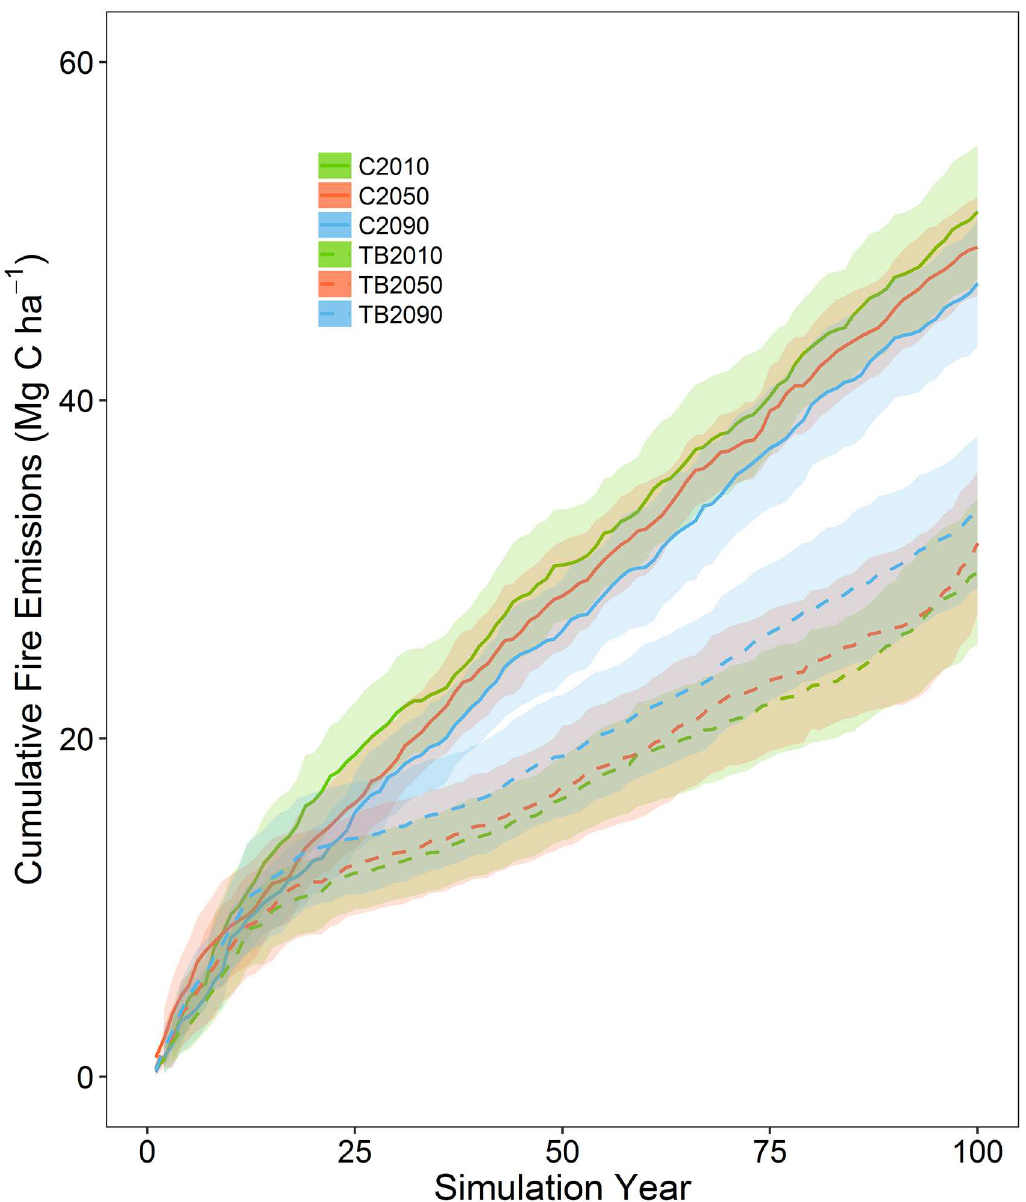
Fig 3. Mean cumulative wildfire and prescribed fire emissions for two simulated treatments (control (C), thin and burn (TB)) under three different climate periods (2010–2019, 2050–2059, 2090–2099)with the same wildfire parameterization over the 100-yearsimulation period. Shadedareas are the 95%